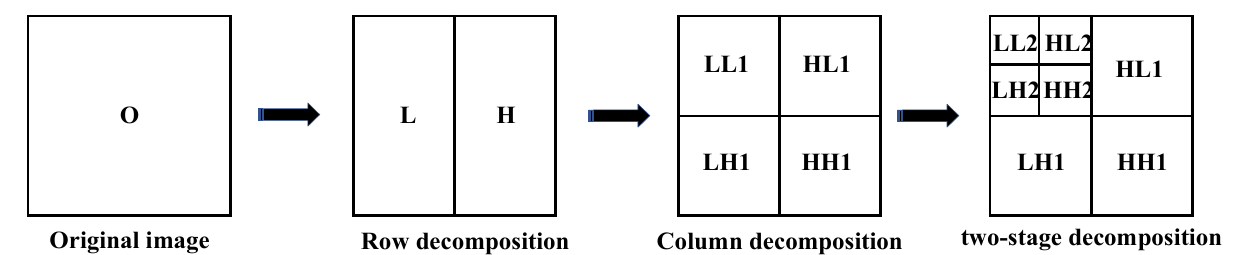
Figure 3. Flow chart of two-dimensional wavelet transform. The horizontal parameters of the original image O, which are low-frequency component L and high-frequency component H, can be obtained by performing one-dimensional wavelet transform on each row of the image; then, a one-dimensional wavelet transform is performed on each column of the transformed image O (L,H), and the parameters in the horizontal and vertical directions of the original image can be obtained; that is, the low-frequency component LL and the high-frequency component HH. At the same time, the high-frequency component LH and the low-frequency component HL can be obtained in the cross direction. HH represents the horizontal and vertical high-frequency components, indicating the details of the diagonal direction. LH represents horizontal low-frequency and vertical high-frequency parameters that indicate detailed information in the vertical direction. HL represents the horizontal high-frequency and vertical low-frequency parameters, which indicate the horizontal detail information.